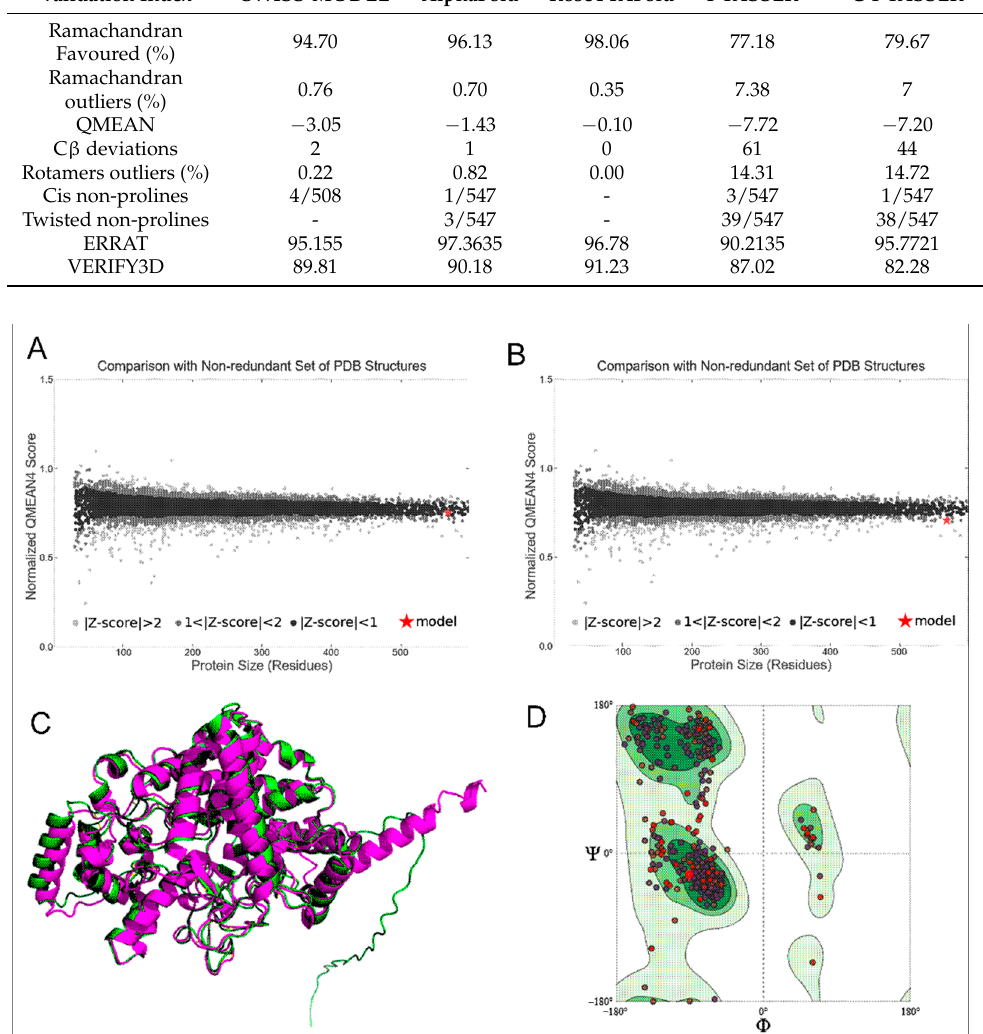
Figure 1. ( A ) Normalised QMEAN score of Ag Tre structure predicted from RoseTTAFold; ( B ) normalised QMEAN score of Ag Tre structure predicted by AlphaFold; ( C ) predicted 3D structure of Ag Tre. Green: predicted structure from AlphaFold. Purple: predicted structure using RoseTTAFold. RMSD of 0.896 Å considering 476/570 residues; ( D ) Ramachandran plot of the Ag Tre structure predicted using RoseTTAFold showing 98.06% of residues in Ramachandran favoured region. Ag Tre: trehalase of An. gambiae